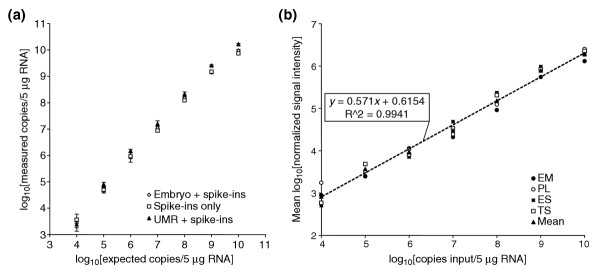
Relating yeast spike-in RNA control copy number to qPCR measurements and microarray signal intensity. (a) To verify abundances of yeast sequence RNA transcripts in a control mixture, cDNA was transcribed from the control mixture alone (open boxes), as well as E12.5 whole-mouse embryo total RNA (open diamonds) and Universal Mouse RNA (filled triangles) with added spike-in control mixture. The cDNA was used as template for real-time PCR quantitation of each yeast sequence RNA, using a separately prepared standard of cDNA transcribed from the yeast sequences. Expected and measured copy numbers are closely matched (r2 ≥ 0.99), with maximum measured/observed ratios of 1.5, 1.5, and 2.6, respectively. (b) Expression profiles were generated for triplicate total RNA samples from E12.5 embryo (filled circles), E12.5 placenta (open circles), ES cells (filled boxes), and TS cells (open boxes) with yeast sequence control transcripts spiked-in prior to target labeling. For the seven control transcripts, mean log10[intensity] is shown for each tissue type, as well as the mean across all samples (filled triangles), and these data were used to perform linear regression analysis and relate signal intensity to transcript copy number, allowing abundance estimation for endogenous transcripts. The regression line for the average of all tissues (dashed line) and its equation is shown. Intensity-copy number correlations for individual tissues were very strong, with r2 values of 0.98 - 0.99.